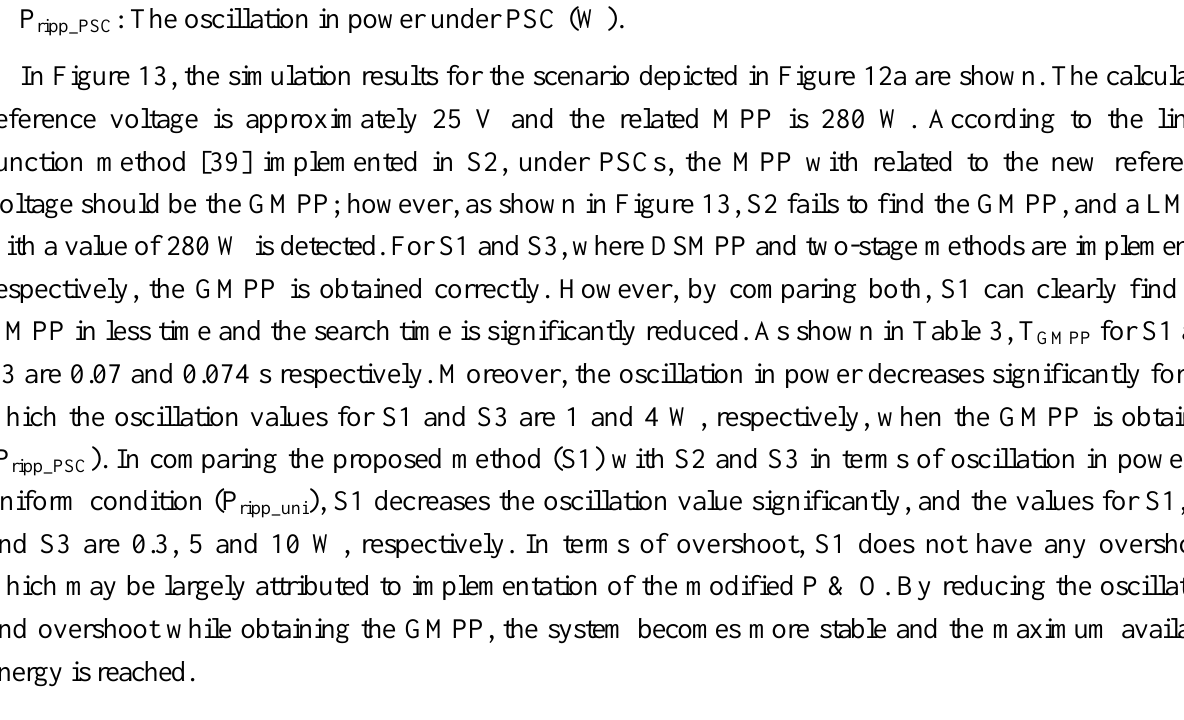
Table 3. The simulation result for S1, S2 and